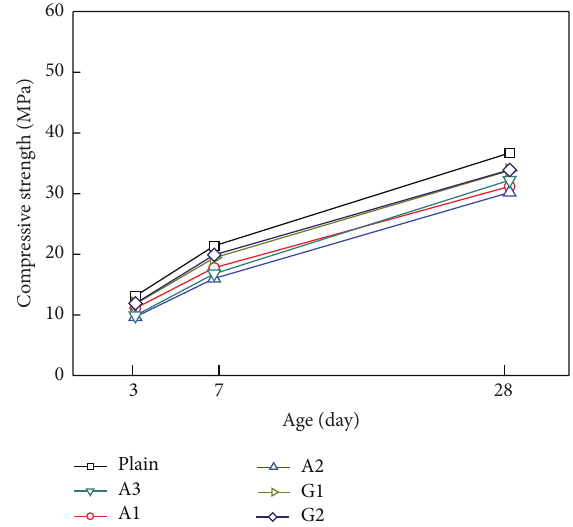
Figure 3: Compressive strength by age for various shrinkage reducing